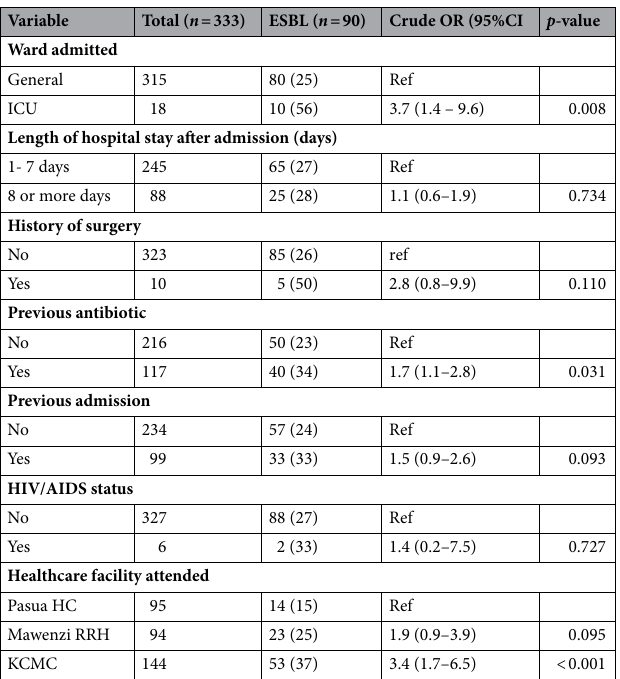
Table 4. Bivariable analysis of factor associated with carriage of Extended-spectrum beta-lactamase (ESBL) producing Enterobacteriaceae (EPE) in feces at